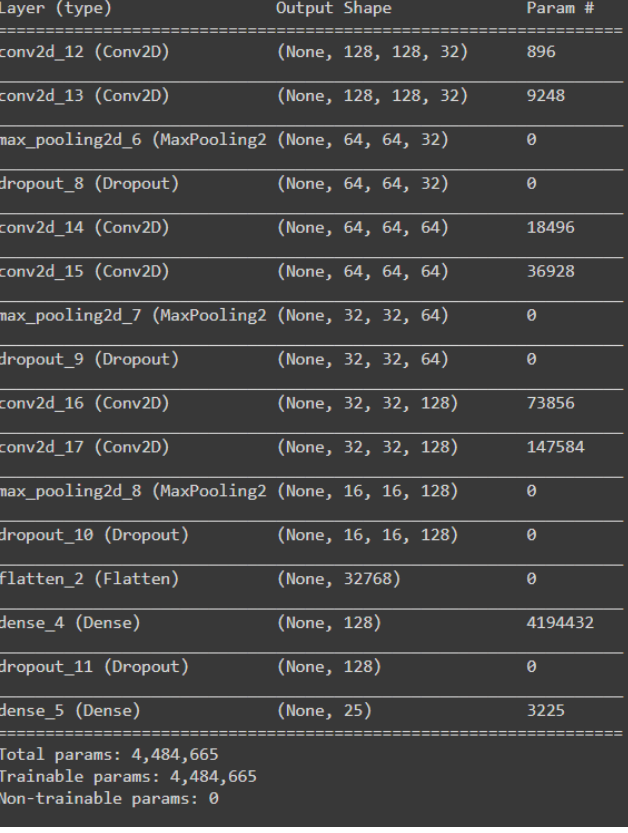
Fig. 2. VGG16 inspired Model